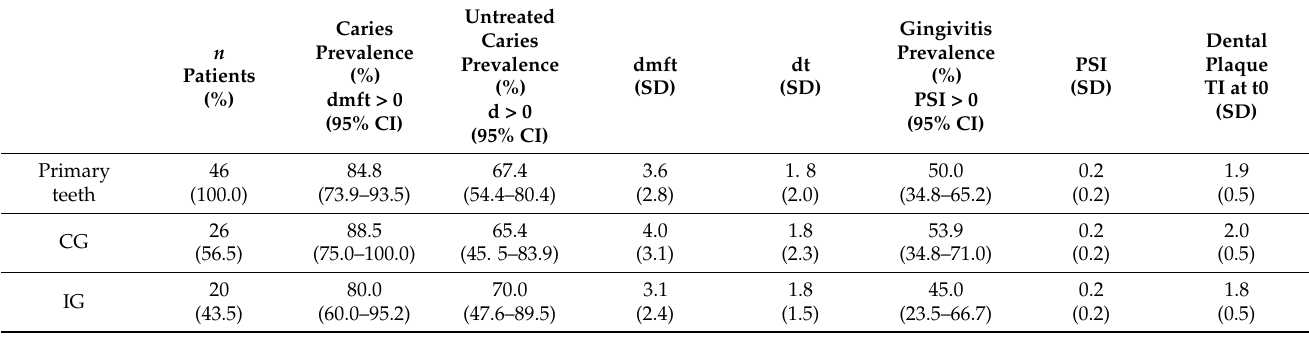
Table 2. Oral health in child and adolescent psychiatric in-patients at the beginning